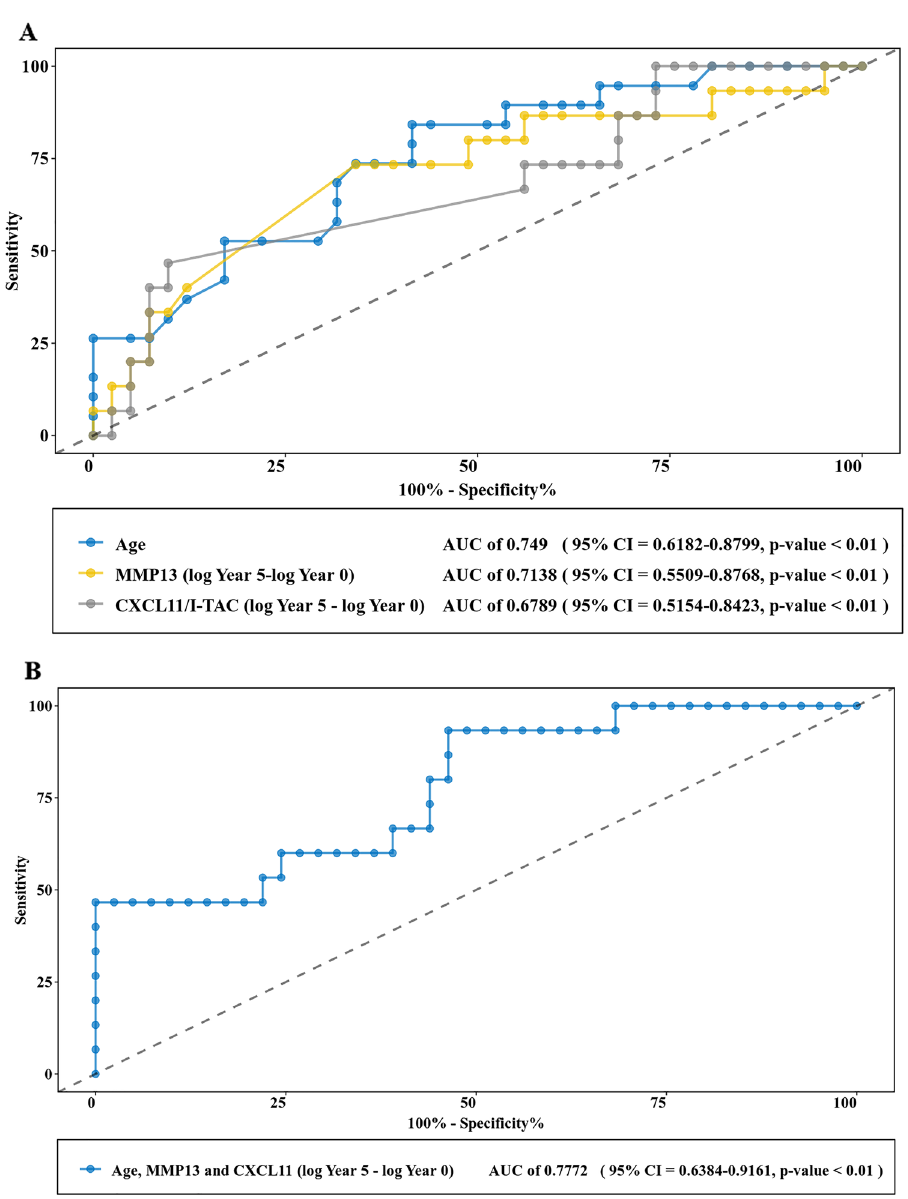
model. ROC analyses for models based on individual parameters of age, changes in MMP13 level, or changes in CXCL11 level (3a) versus the combination of age, changes in MMP13 level, and changes in CXCL11 level reflect variables associated with the risk of progression in RA-ILD (as measured by Quantitative Modified ILD scores). The respective AUCs for these models are 0.749 (age), 0.7138 (change in MMP-13), 0.6789 (change in CXCL11) and 0.7772 (combined variables)—all with p <